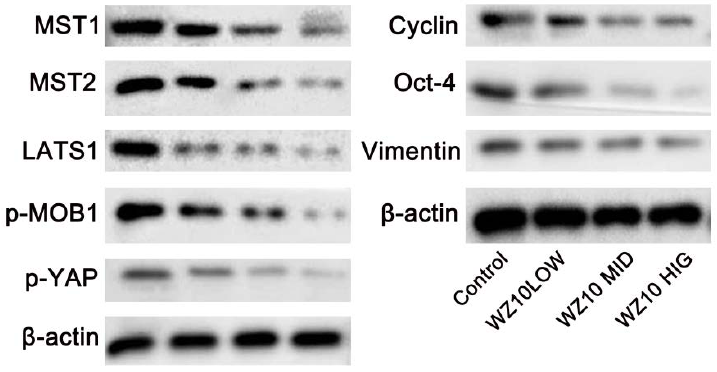
Figure 2. WZ10 inhibits Hippo-YAP pathway in ovarian cancer cells.